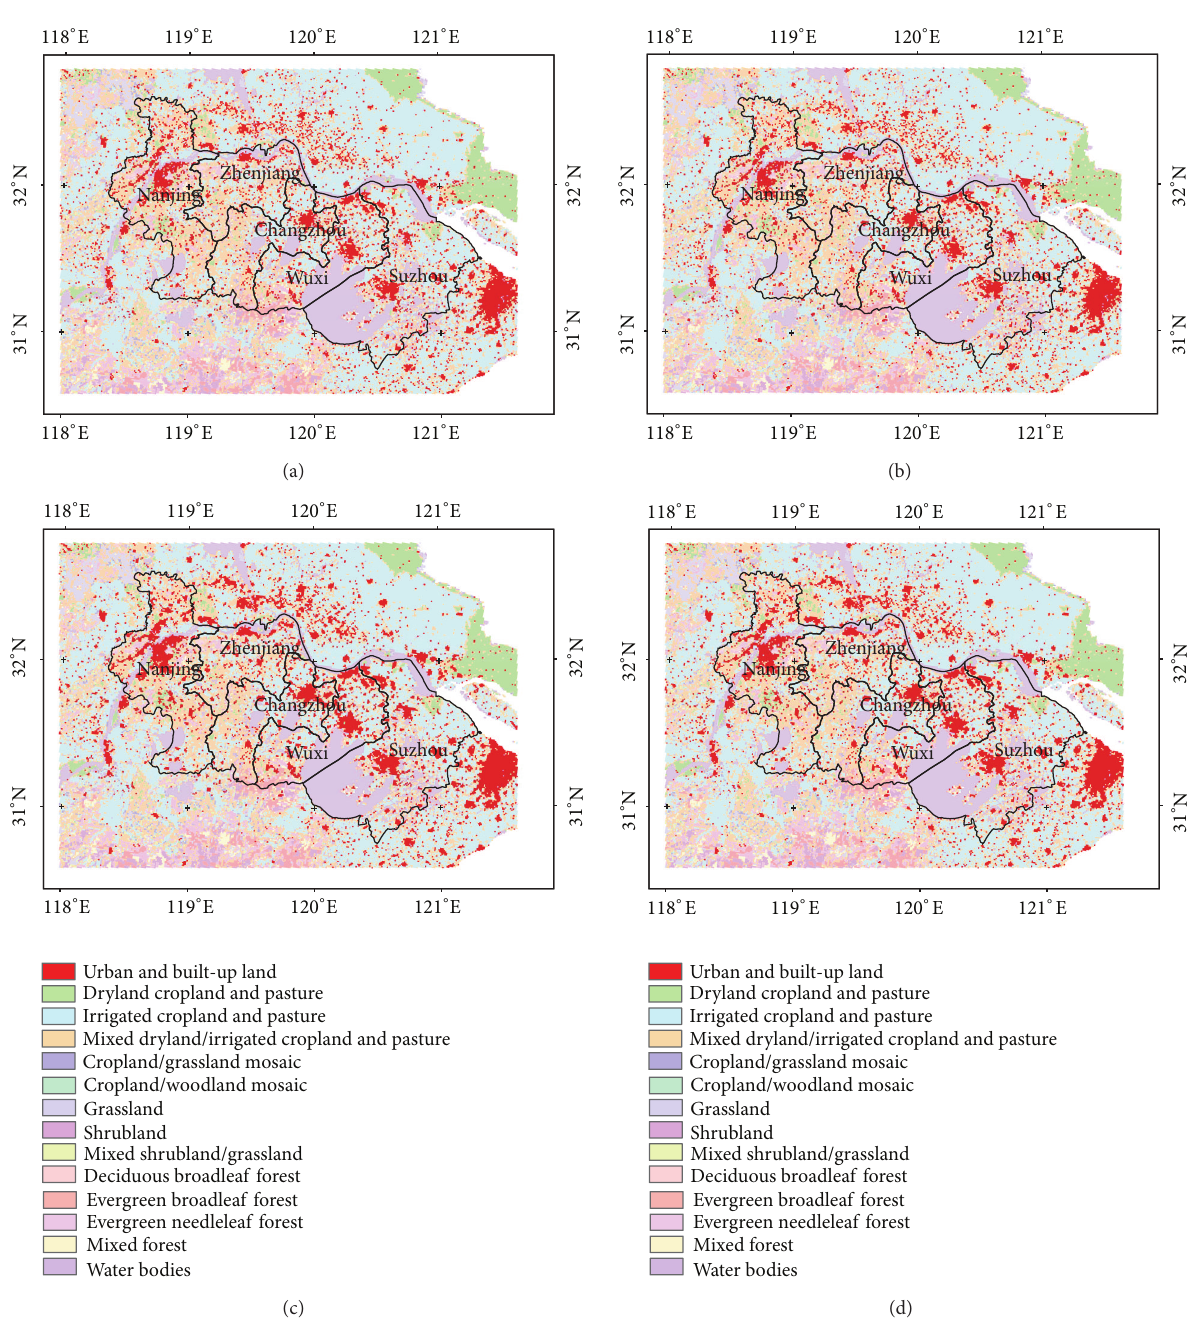
Figure 4: Results of land use change simulation. (a) and (b) show the simulation results of land use in Southern-Jiangsu in year 2010 under REG scenario and CES scenario, respectively; (c) and (d) show the simulation results of land use in Southern-Jiangsu in year 2050 under REG scenario and CES scenario,